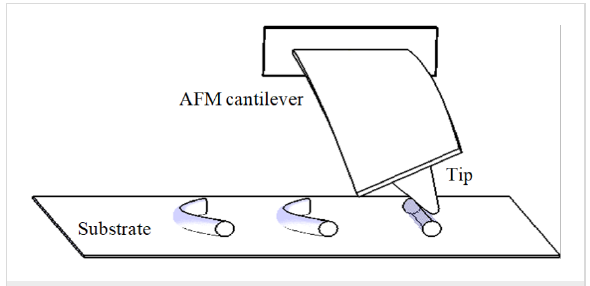
Figure 1: Schematic of the manipulation process of a cylindrical nano- particle by means of AFM.